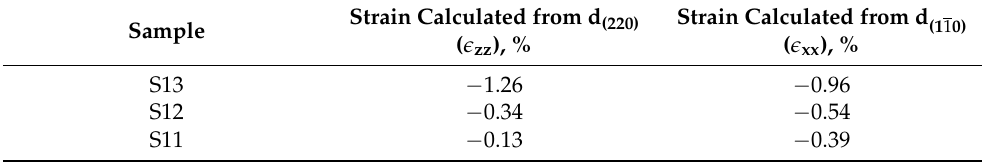
Figure 4. In-plane 2 θχ / φ measurement of the α -Bi (110) plane. The vertical dashed lines show theoretical 2 θ values for the planes mentioned above. Interplanar spacing dependencies on the layer thickness are shown in the insets. Table 3. Strain calculated from two planes for α -Bi layers with different